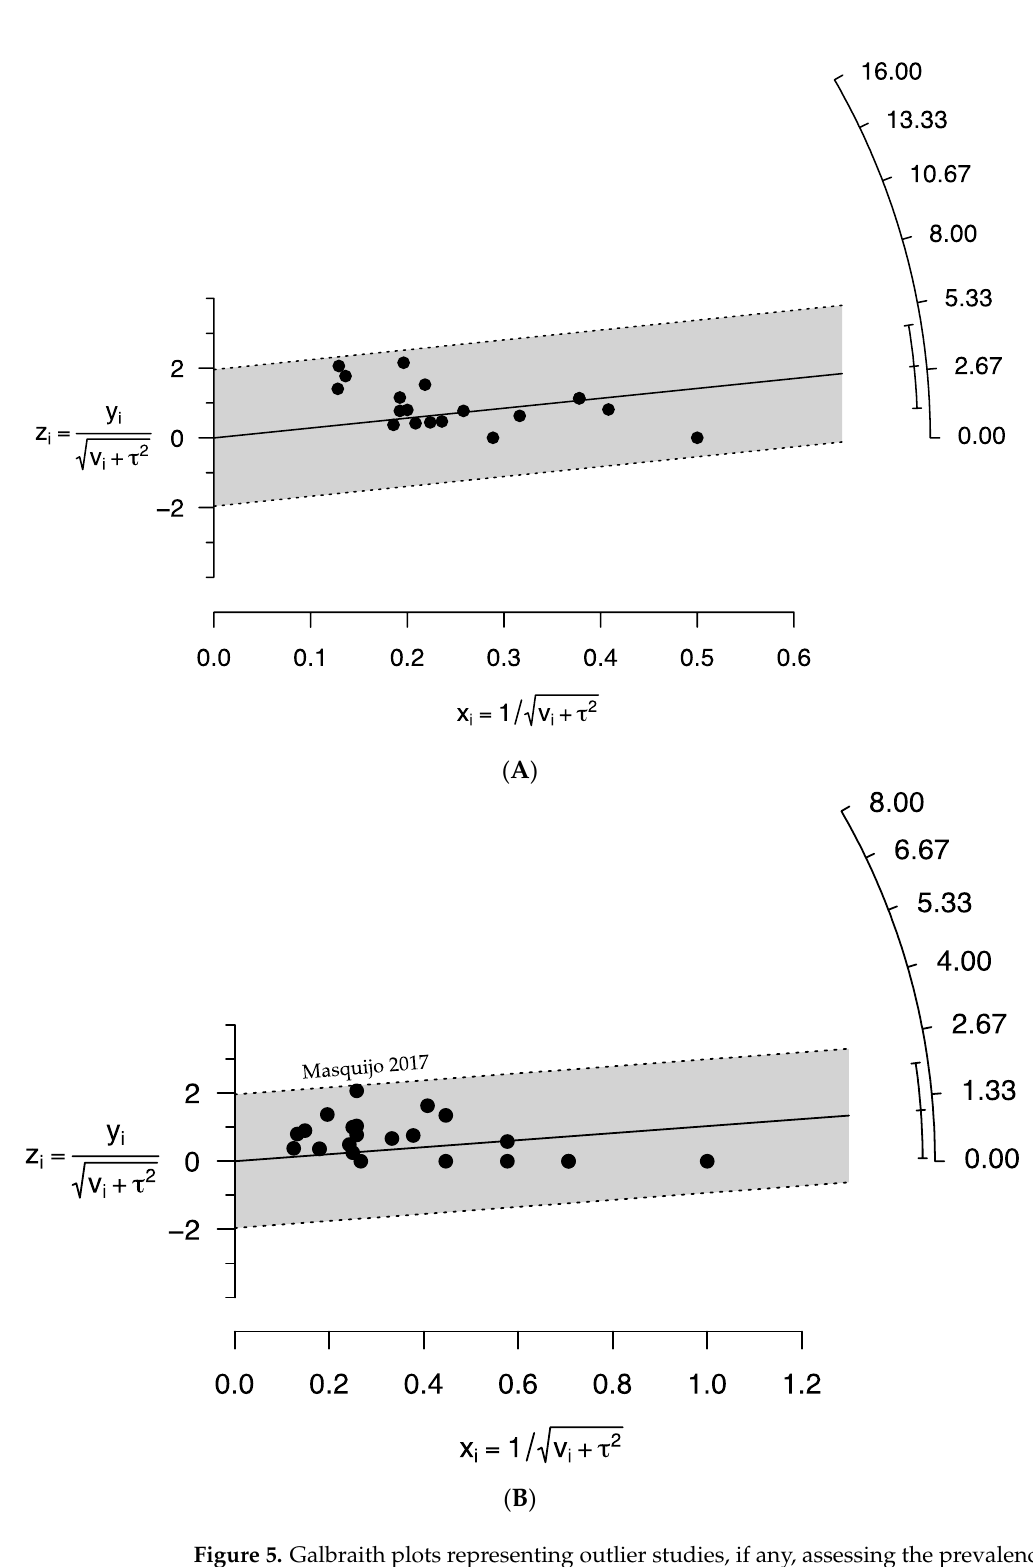
Figure 5. Galbraith plots representing outlier studies, if any, assessing the prevalence of avascular necrosis followed by ( A ) closed pinning and ( B ) open reduction in patients with unstable slipped capital femoral epiphysis.